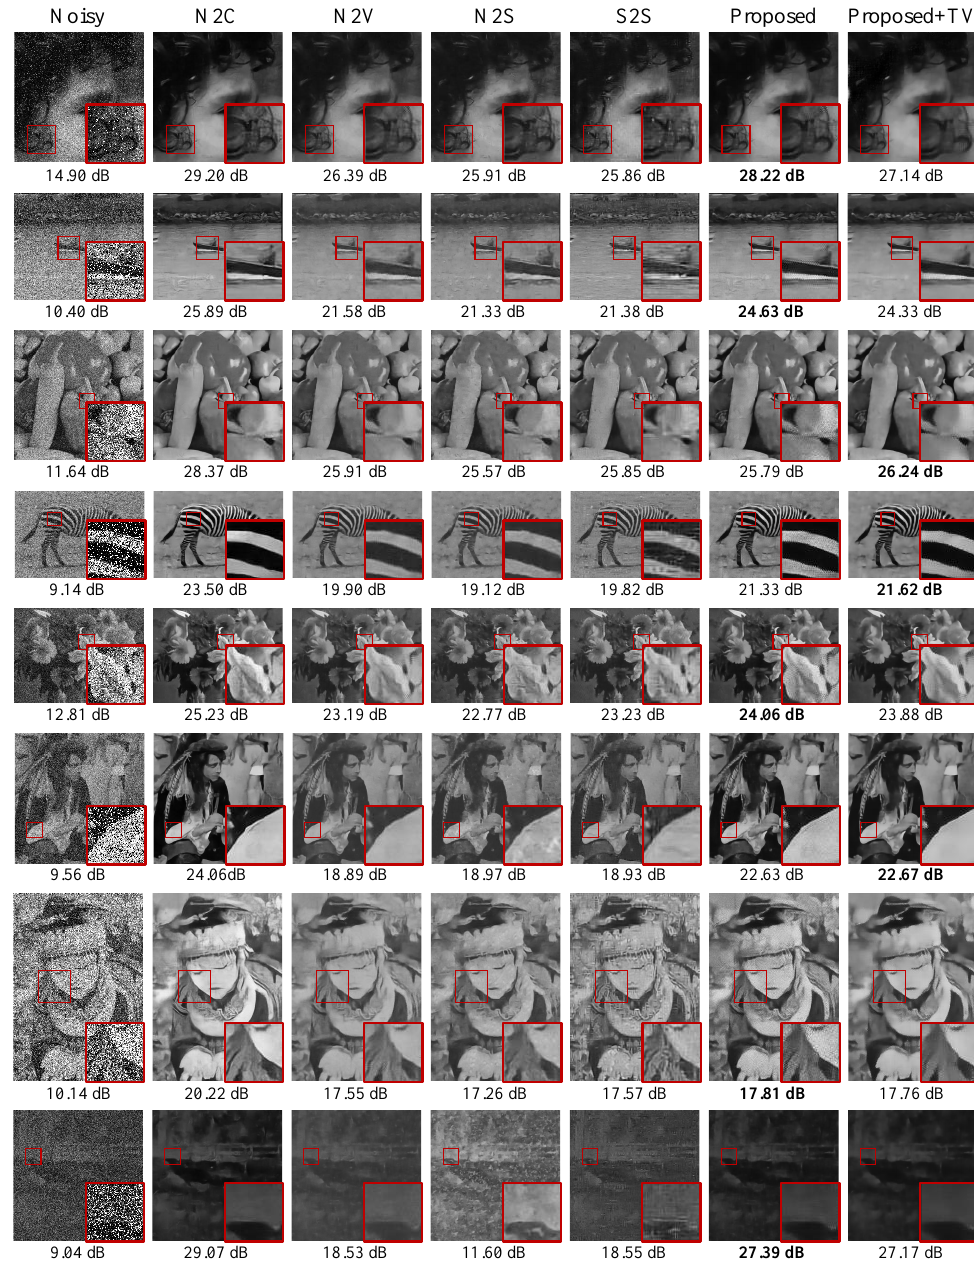
Figure 6. Qualitative performance comparison of various denoising methods on fusion noise. Top to bottom ( σ g , σ s , d): (25,5,5), (25,5,25), (25,25,5), (25,25,25), (50, 5, 5), (50, 5, 25), (50, 25, 5), (50, 25, 25), respectively. The best PSNR is highlighted in bold, except